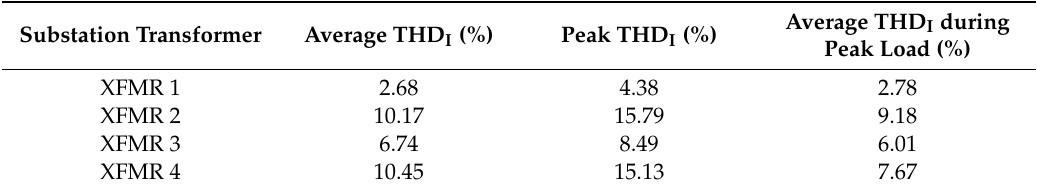
Table 2. Harmonic current monitoring results.